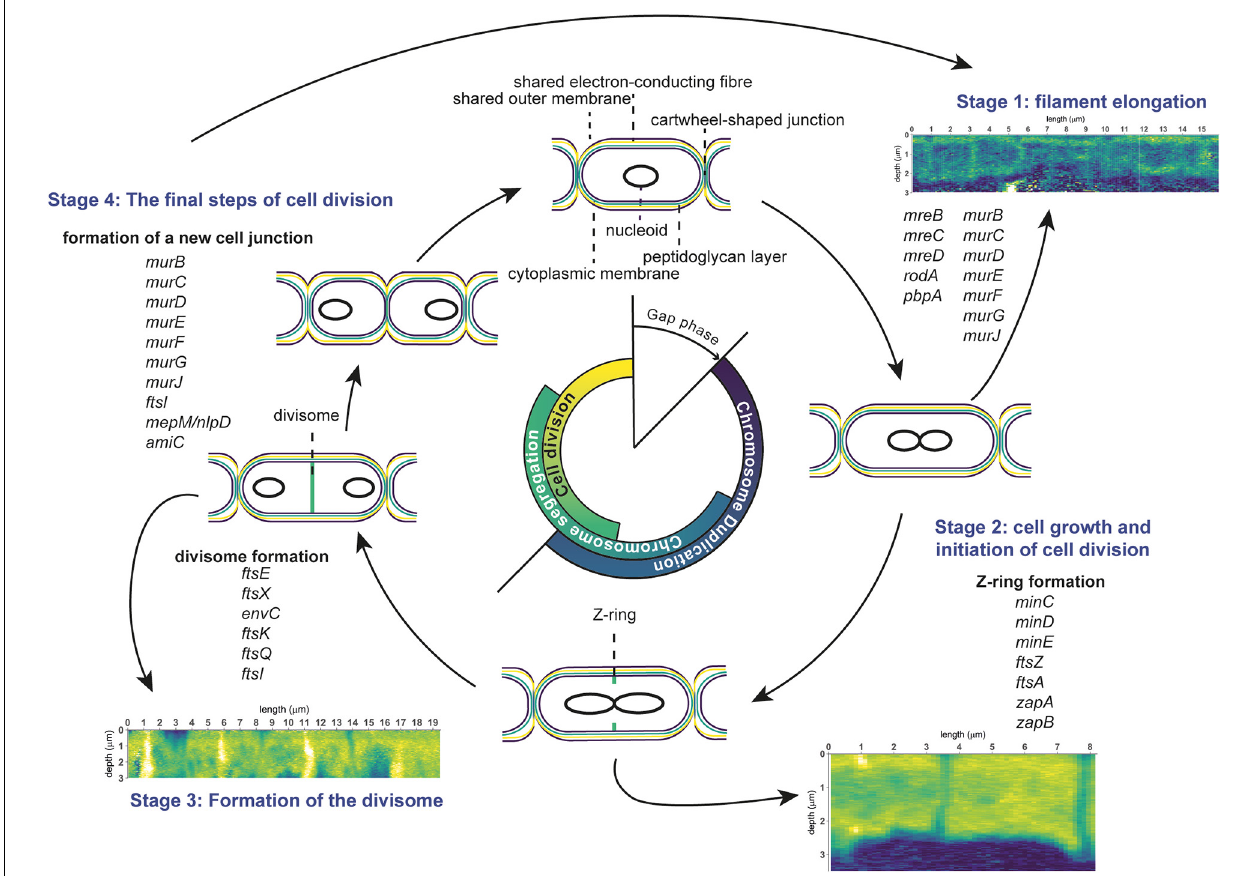
FIGURE 6 | Schematic overview of the cell division cycle in cable bacteria. Cell cycle events are shown, together with the corresponding stages observed in nanoSIMS images ( 13 C atom fraction), as well as information from genome analysis of cable bacteria (genes involved in cell division). The three stages represent cell elongation, cell growth and cell division. See text for